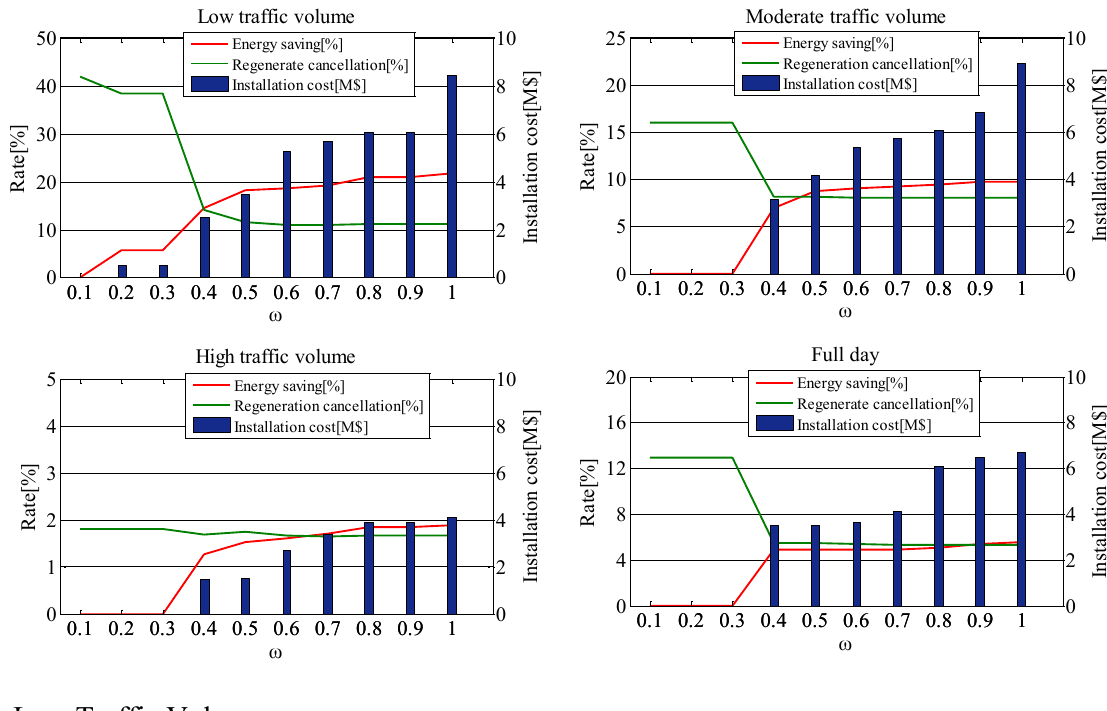
Figure 21. Optimized results under different traffic volumes.